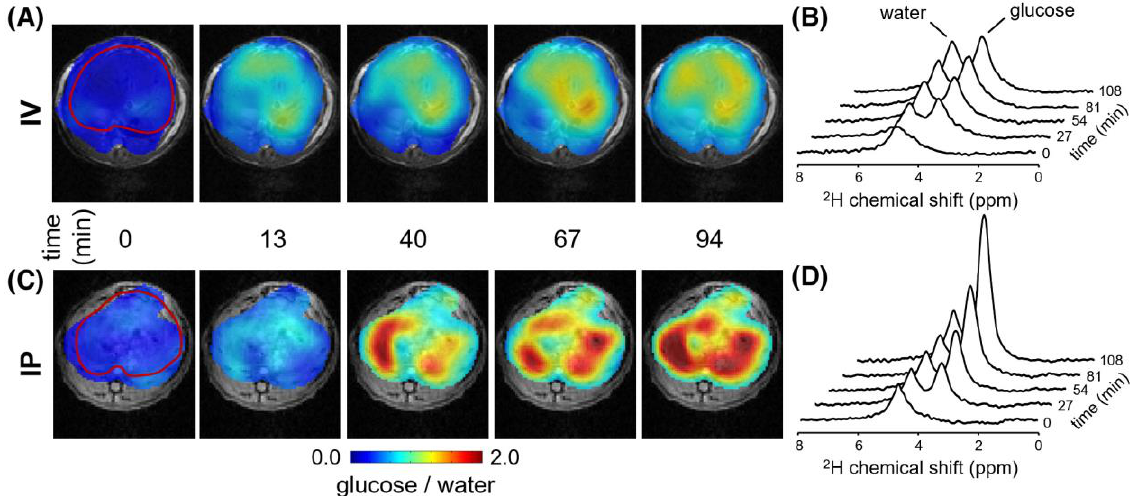
Figure 3. Metabolic maps of glucose/water ratio ( A , C ) and dynamic 2 H spectra ( B , D ) in the rat liver (indicated by the red line in panels A and C for t = 0) after intravenous (IV) infusion ( A , B ) and intraperitoneal (IP) infusion ( C , D ) of [6,6 (cid:48) - 2 H 2 ]glucose. Glucose signal reached higher intensities after IP infusion compared to IV infusion, as can be seen in both colormaps and dynamic 2 H spectra. This figure was adapted from Reference [38], with